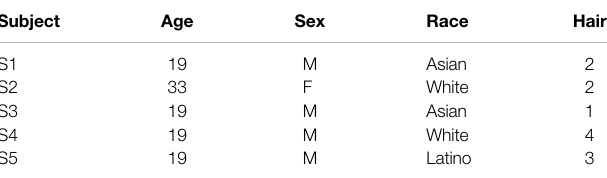
TABLE4| Demographicsofsubjectswhovolunteeredtobepartofthestudy.Hair stands for calf hair and was ranked on ascale from 1 to 5 where 1 was no hair and 5 was very